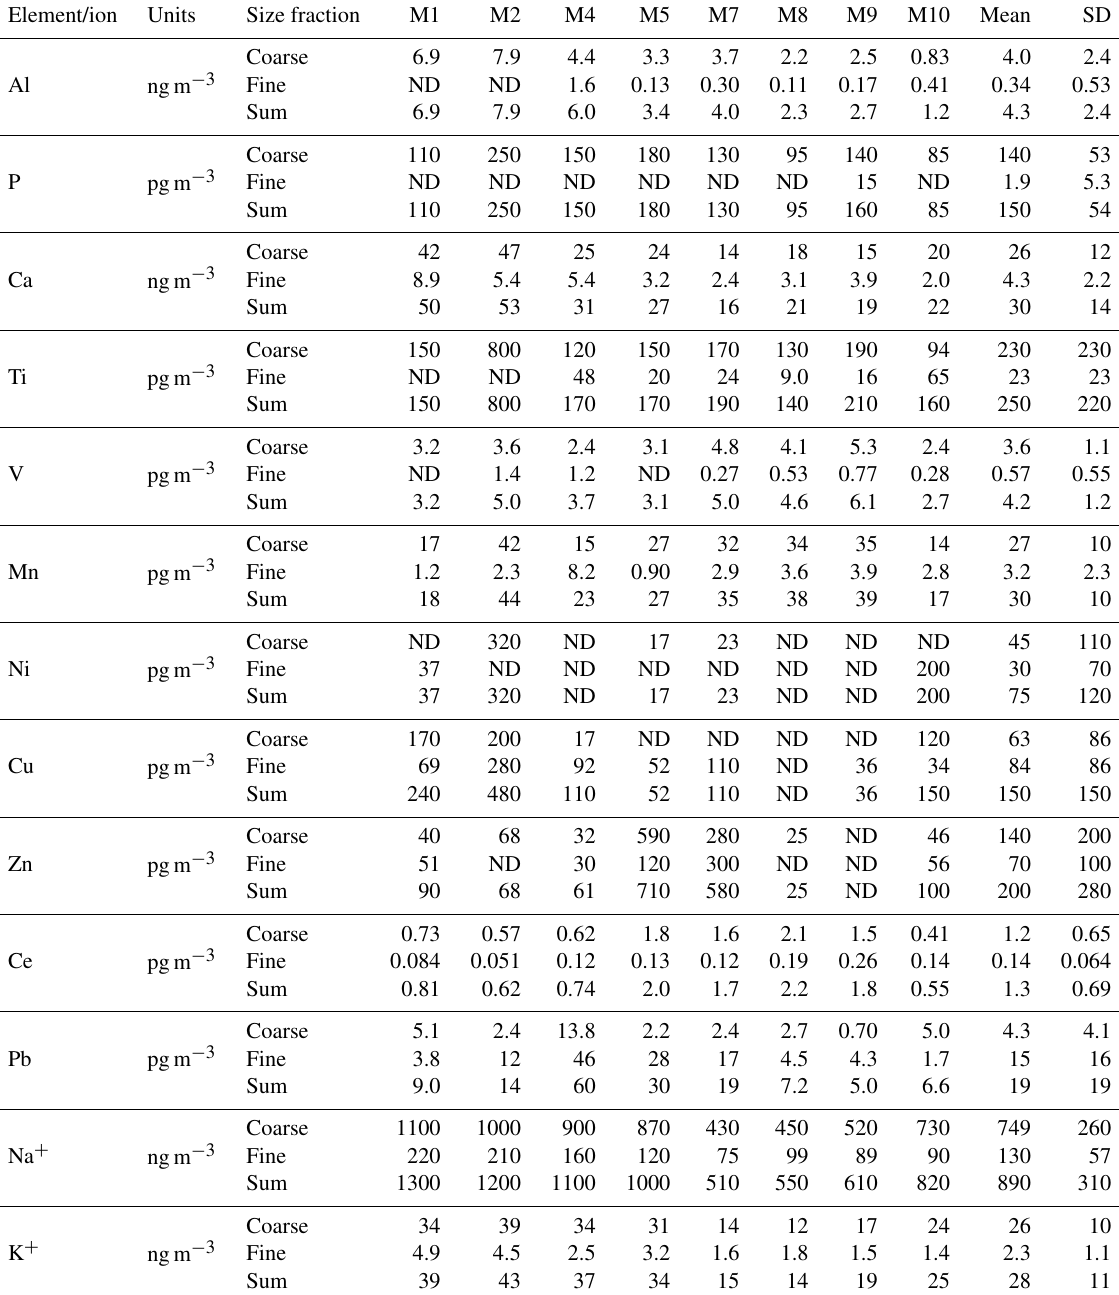
Table 2. Concentrations of trace elements and ions in aerosols over Palmer Station, western Antarctic Peninsula.